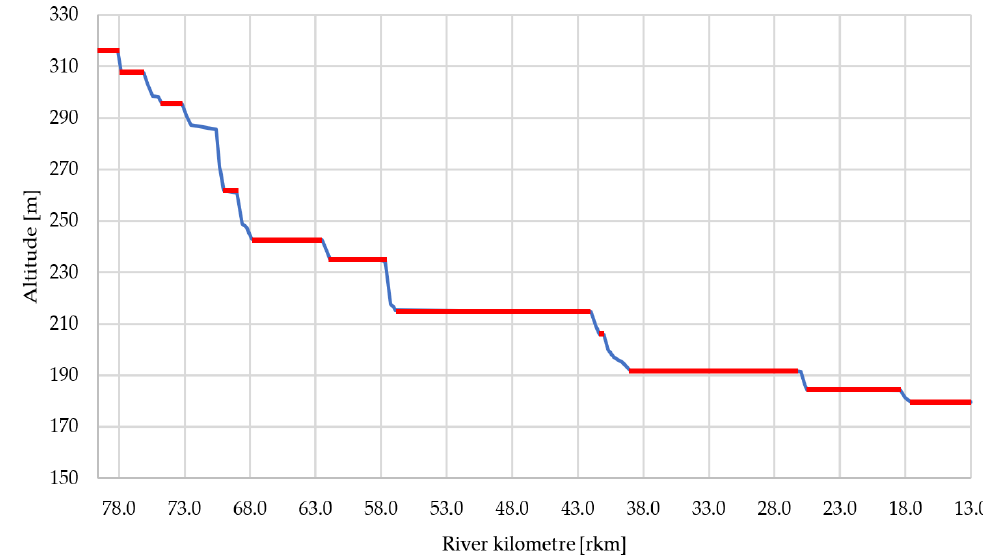
Figure 5. Elevation profile of a selected part of the Torysa River and marking of sections with an insufficient head.